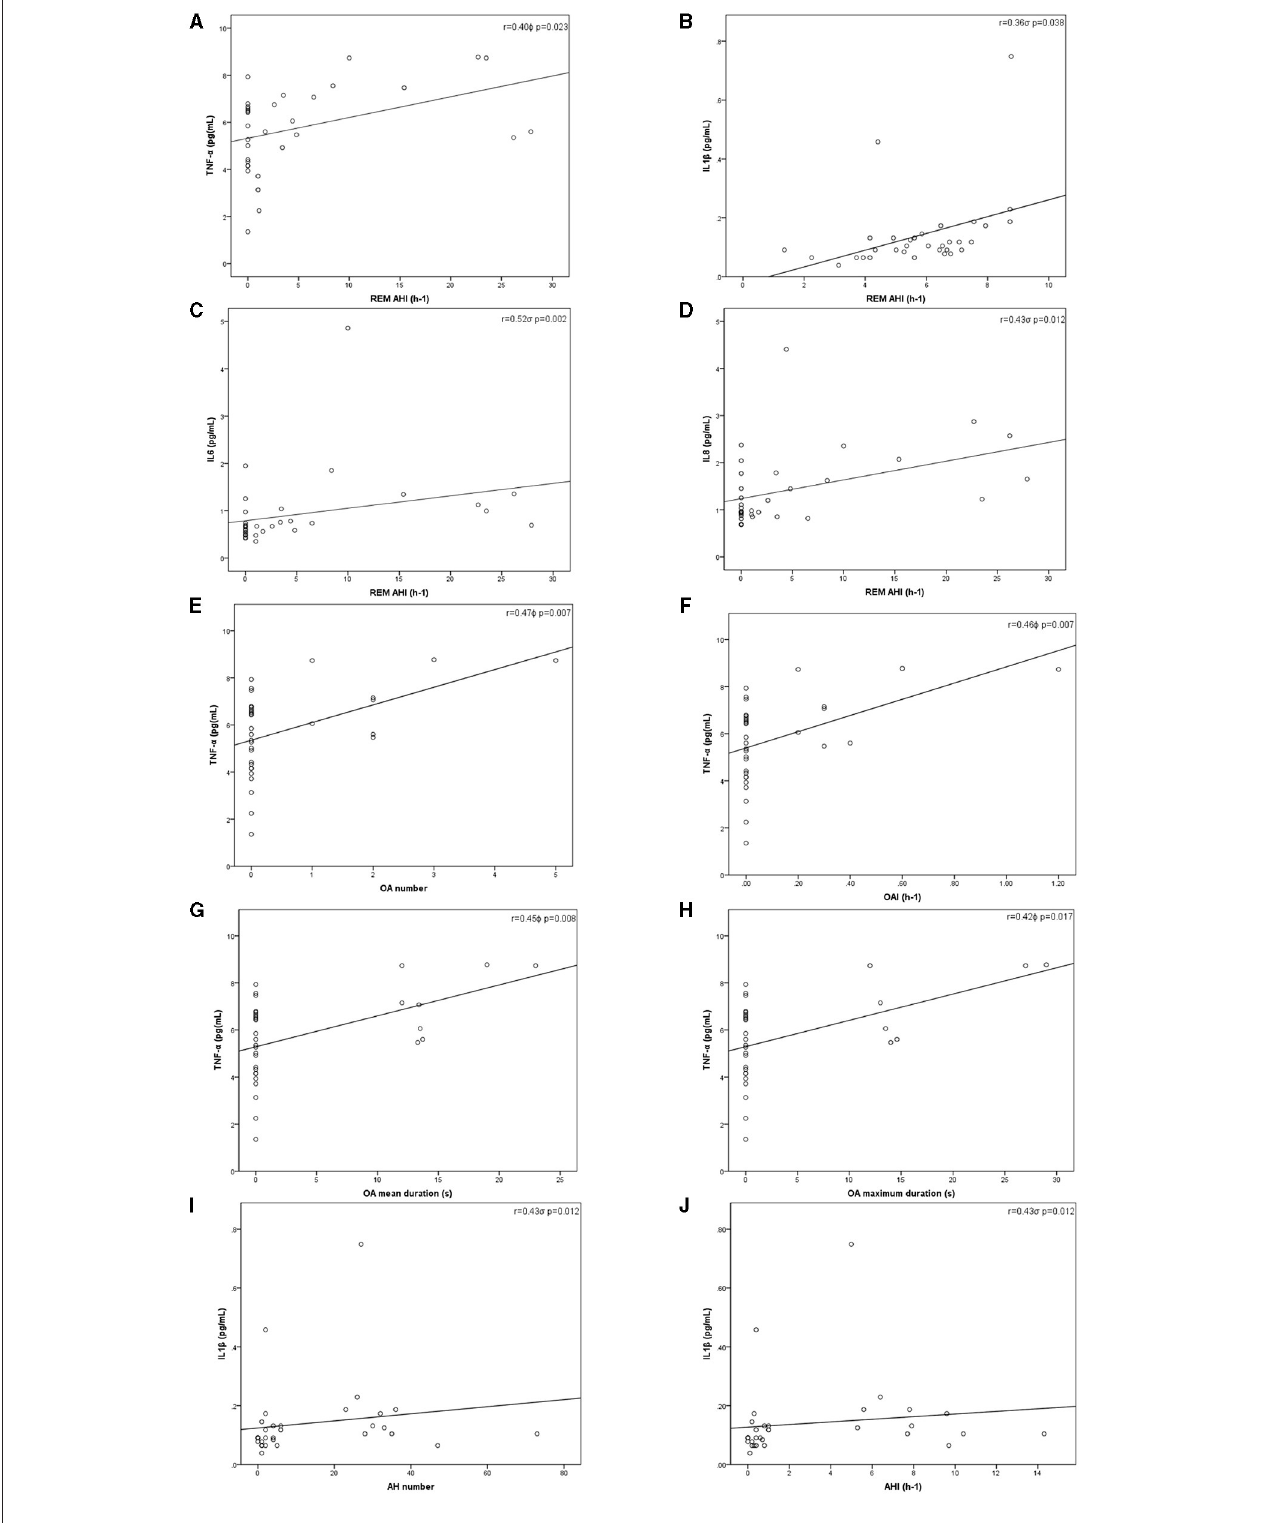
FIGURE 2 | Inflammatory cytokines levels and sleep study parameters correlations. Pearson φ (TNF- α ) and Rho de Spearman σ (IL-1 β , IL-6, IL-8, and IL-10) correlations. (A) Correlation between TNF- α and REM AHI φ ; (B) Correlation between IL-1 β and REM AHI σ ; (C) Correlation between IL-6 and REM AHI σ ; (D) Correlation between IL-8 and REM AHI σ ; (E) Correlation between TNF- α and the total number of OA φ ; (F) Correlation between TNF- α and OAI φ ; (G) Correlation